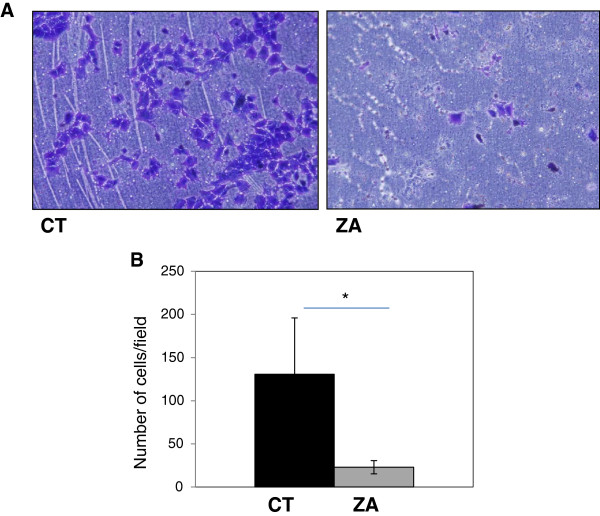
Effect of zoledronic acid (ZA) on Ewing’s sarcoma cell invasion through Matrigel. Human A-673 ES cells were seeded and cultured for 24 hours in the presence of ZA. Then 4.104 cells were placed on the top of the Boyden’s chamber and left to invade the Matrigel 48 h without ZA. A. Microscopic observation (×10) of ES cells on the bottom of the Boyden’s chamber at the end of the 24 h. B. mean number of cells /field after invasion assay in Boyden’s chamber recovered by Matrigel. (*: p < 0.05).